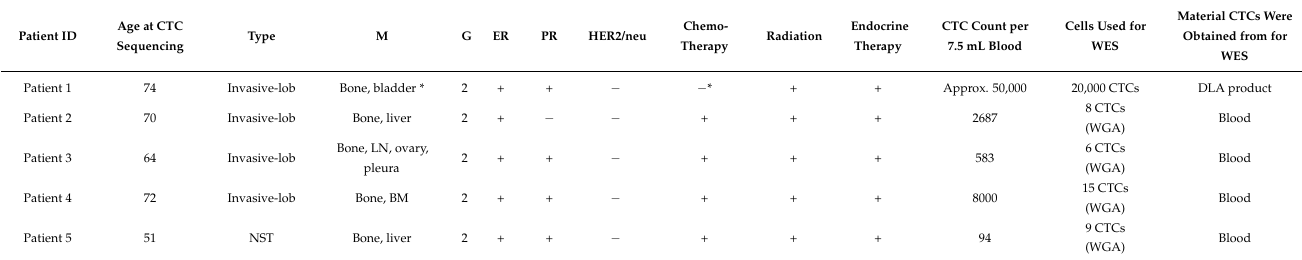
Table 1. Clinical